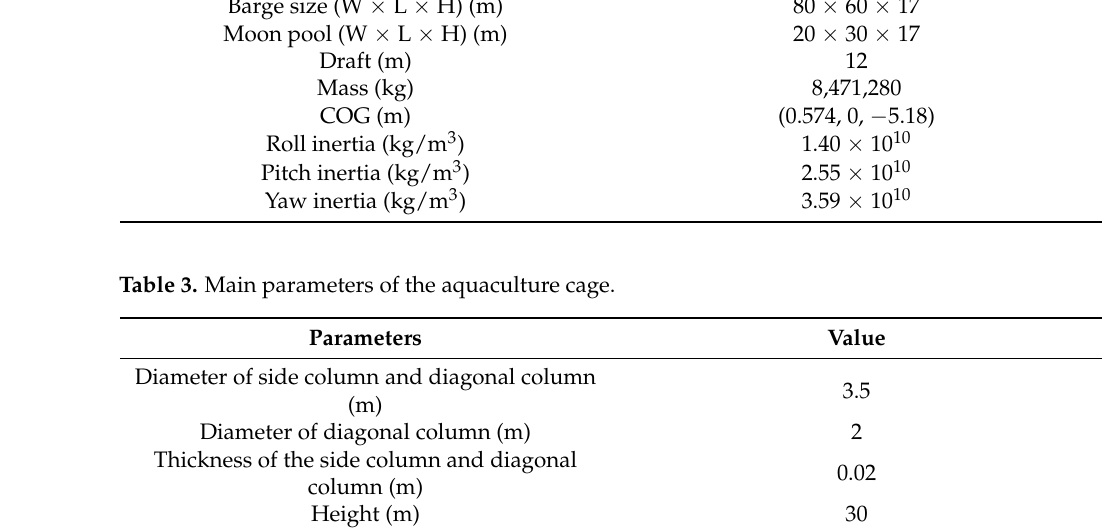
Table 2. Main parameters of the barge-type platform. Parameters